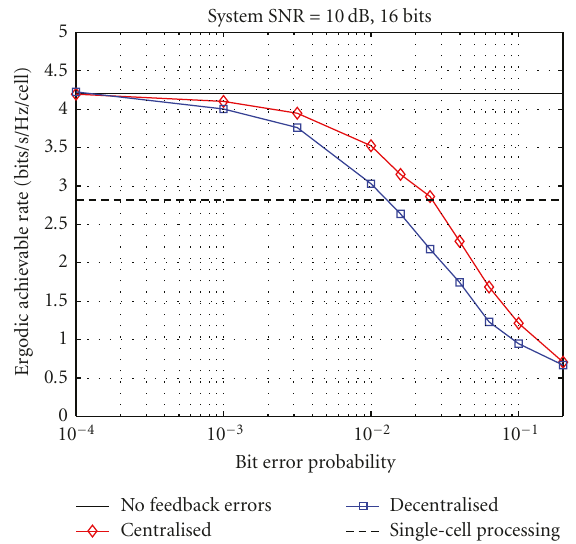
Figure 7: A plot of the ergodic achievable rate as a function of the bit error probability P e for both the decentralised and the centralised frameworks, when System SNR = 10 dB and 16 bits are employed for quantization. In the decentralised case the CSI is fed back through 3 independent radio